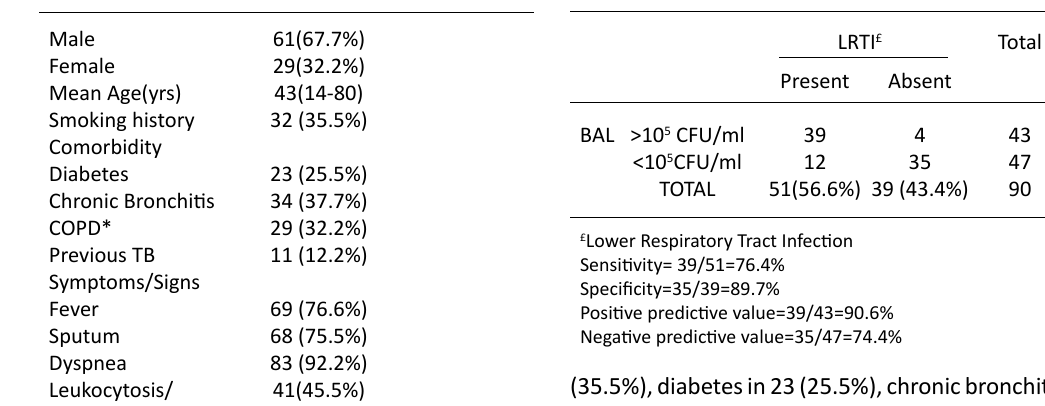
table 1. Clinical profile of patients (n=90) Variables